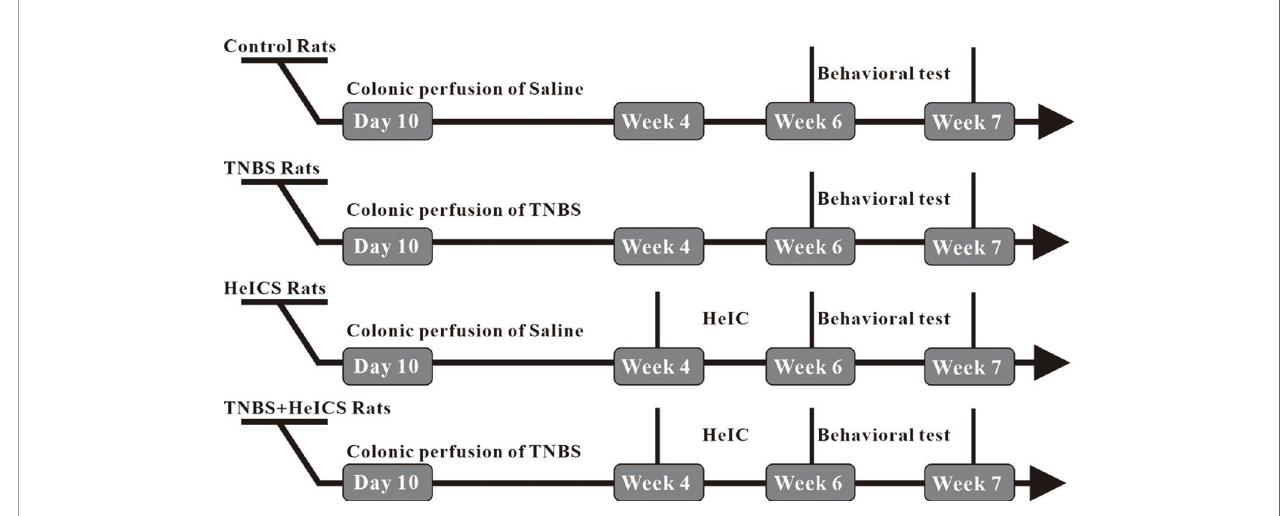
FIGURE 2 | Timeline of chronic visceral pain and anxiety-like behaviors induction